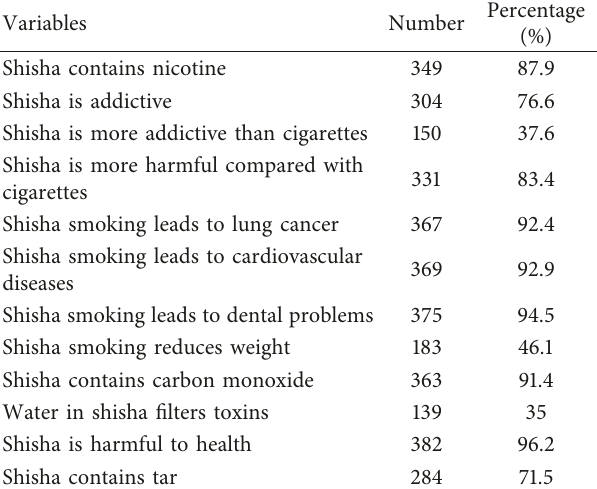
Table 2: Knowledge and awareness about shisha smoking.